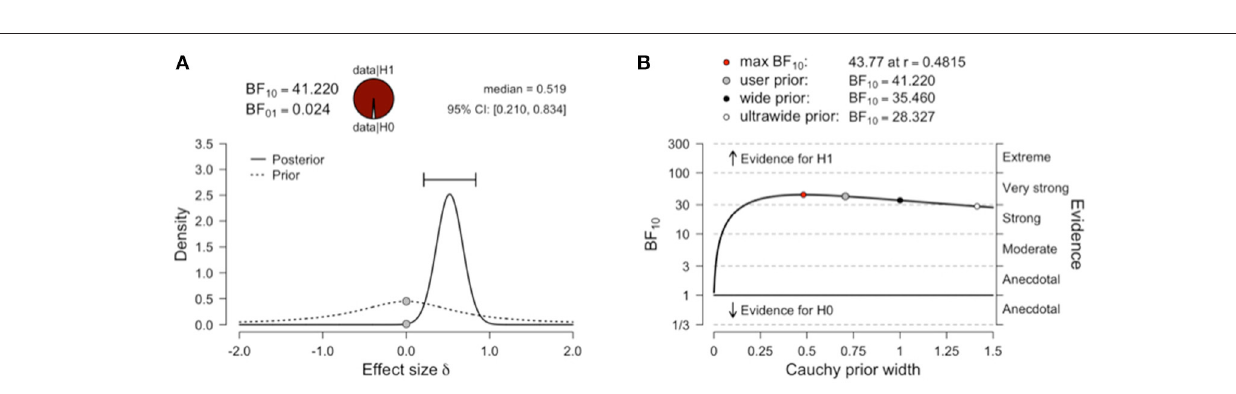
FIGURE 2 | Bayes factor analysis on the Flanker difference score. (A) Prior and posterior; (B) Bayes factor robustness